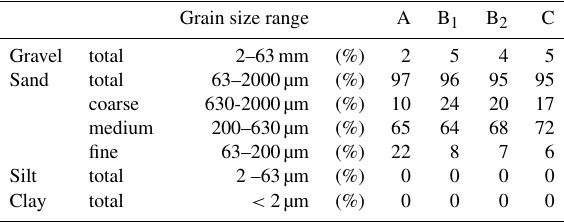
Table 1. The grain size distribution in percent by weight displays the different granularity of the materials A, B, and C of ASSESS (G. Schukraft, personal communication, Institute of Geography, Heidelberg University, 2010). Whereas the composition of the ma- terials B and C is similar, material A features a higher percentage of fine sand. Since the mechanical wet analysis is time-consuming and laborious, only material B was sampled twice. Thus, 80g out of approximately 400Mg were sampled. Due to rounding, the sum of the values is not always